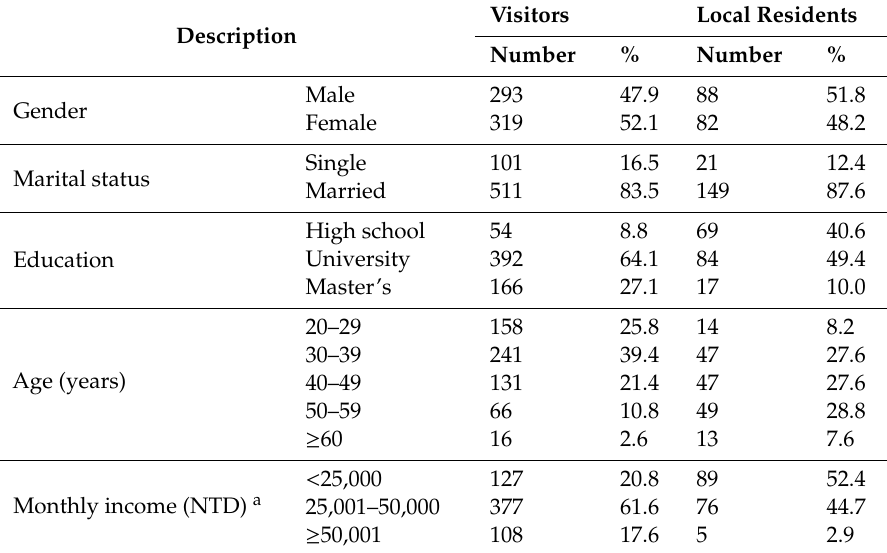
Table 2. Sociodemographic and economic characteristics of the respondents. Visitors Local Description